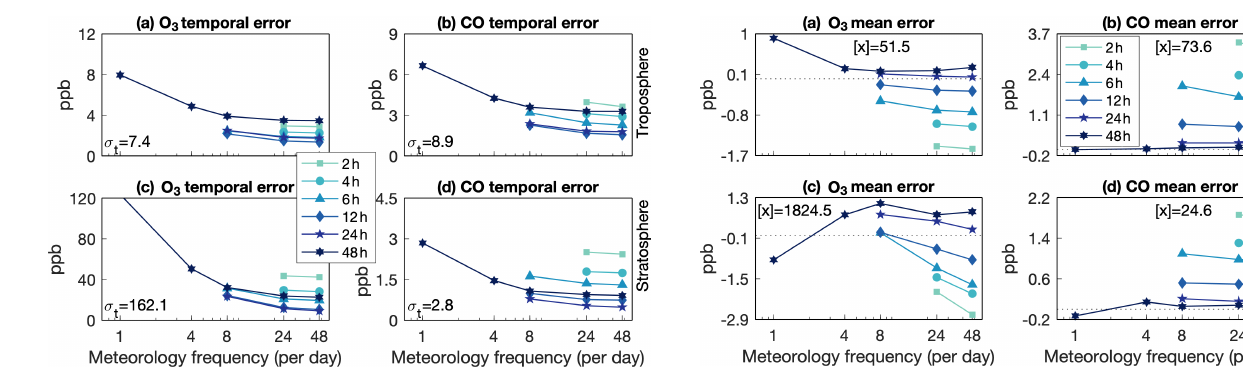
Figure 9. As in Fig. 7 but for the mean error, and the globally and vertically averaged absolute value of each field is shown in each panel.